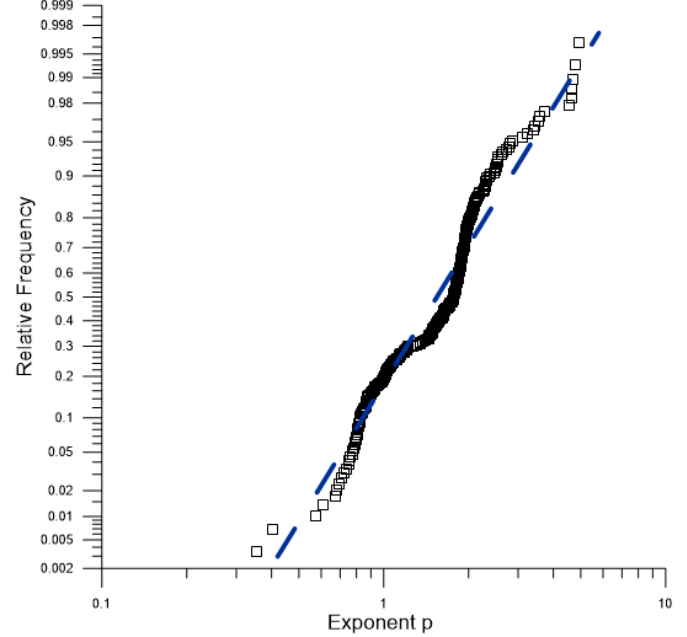
Figure 8. Plot of the parameter p values on a probability diagram.